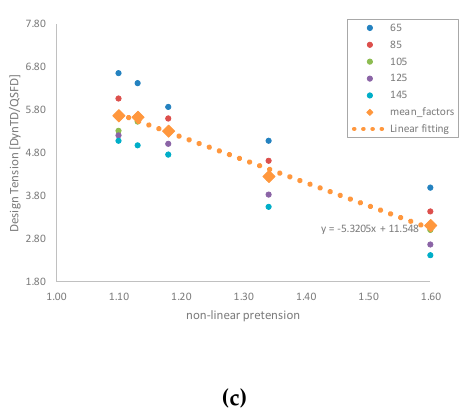
Figure 17. Correction factors between the DynTd and the QSFD models for five linear mass values (65, 85, 105, 125, and 145) and a linear fitting of the mean values for Anchor Radius ( a ), Suspended length ( b ) and Design Tension ( c ).